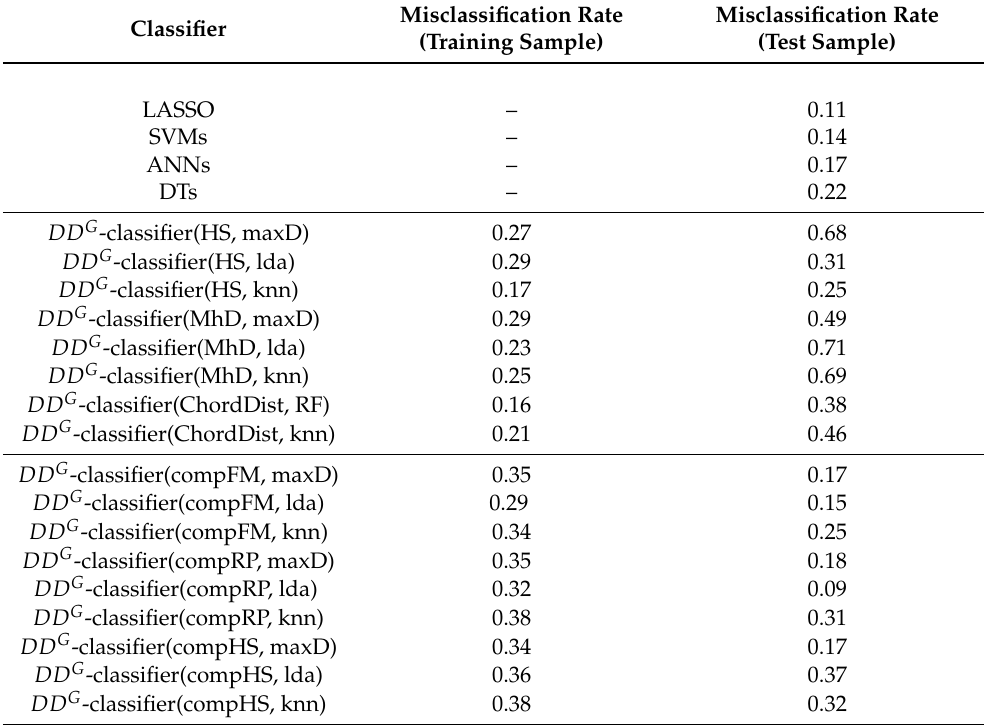
Table 1. Summary table including the results obtained in the analysis carried out in this manuscript, and those obtained in [25] using LASSO, SVMs, ANNs and DT for 65/35% training–test split. The first column indicates the used classifier, the second column indicates the misclassification rate in the training sample and the third column indicates the misclassification rate in the test sample. The row in bold refers to the classifier that performed best in the test sample. Misclassification Rate Misclassification Rate Classifier (Training Sample) (Test Sample) LASSO – 0.11 SVMs